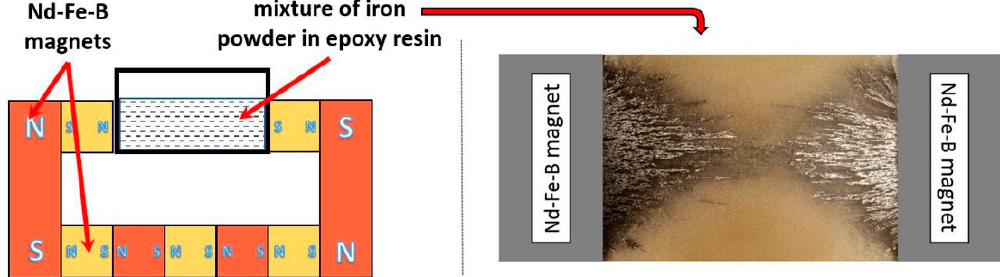
Figure 7. Schema of the located magnets in equipment with fabricated materials and a photo showing the sample with the distribution of iron powder particles.